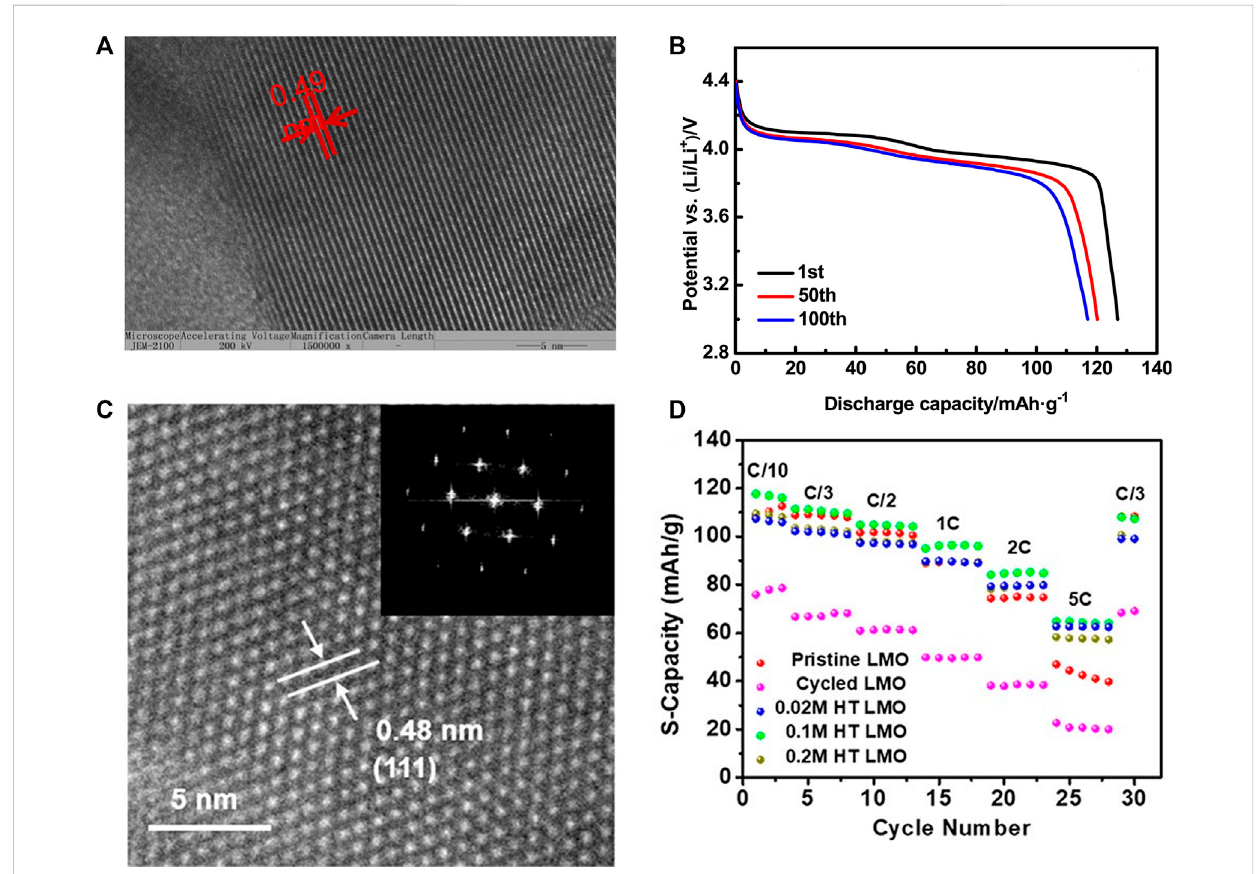
FIGURE 7 (A) HRTEM image of resynthesized LMO; (B) The discharge curves of LMO-750 at 1st, 50th, and 100th; (C) HRTEM images and FFT patterns of regenerated LMO particles in the bulk region; (D) Rate performance of different LMO